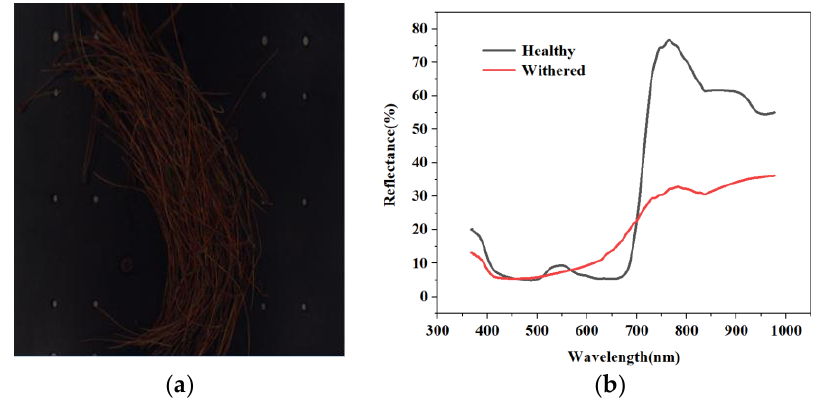
Figure 2. Detection of pine wilt disease using hyperspectral techniques ( a ) Hyperspectral images of diseased pine needles ( b ) Hyperspectral reflectance of healthy and withered masson pine.